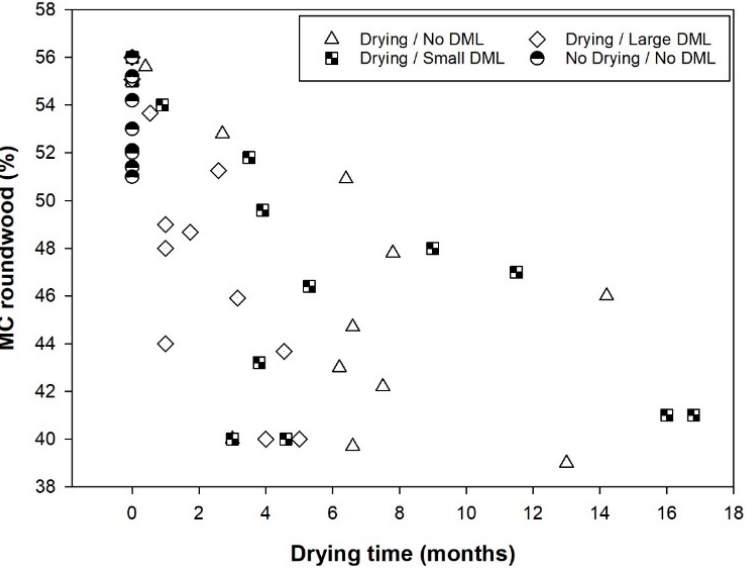
Figure 6. Relationship between the MC of the roundwood delivered to the pulp mill and drying time by scenario.